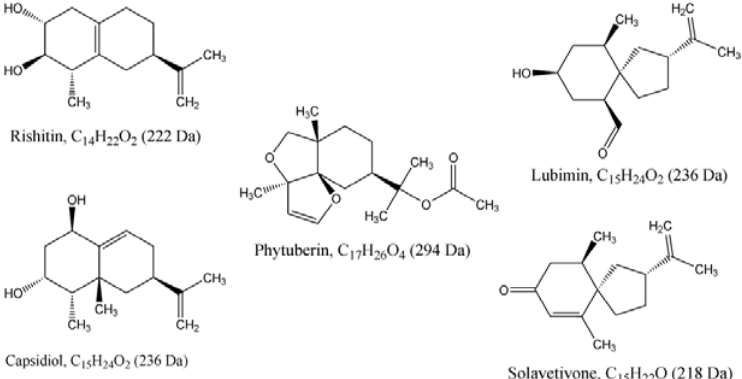
Figure 7. Chemical structures of the five sesquiterpenoid phytoalexins putatively identified in this study. All the sesquiterpenes, by definition, have the basic skeleton of C and are synthesised from a C molecule, farnesyl diphosphate (FPP), through the reactions 15 catalysed by the enzymes prenyltransferase and sesquiterpene cyclases. The end products of these enzymes-catalysed reactions are various sesquiterpenoids with varying number of carbons such as C , C and C 15 14 17